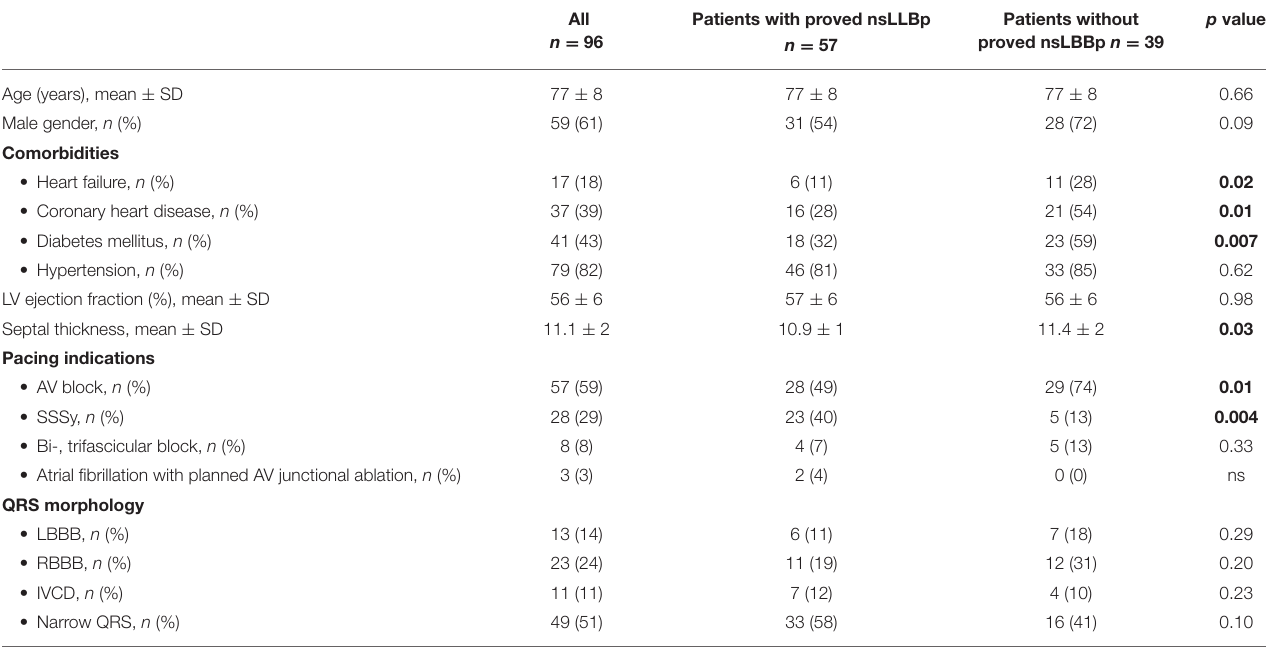
TABLE 1 | Clinical characteristics of all patients and patients with successful and unsuccessful nsLBBp implants.